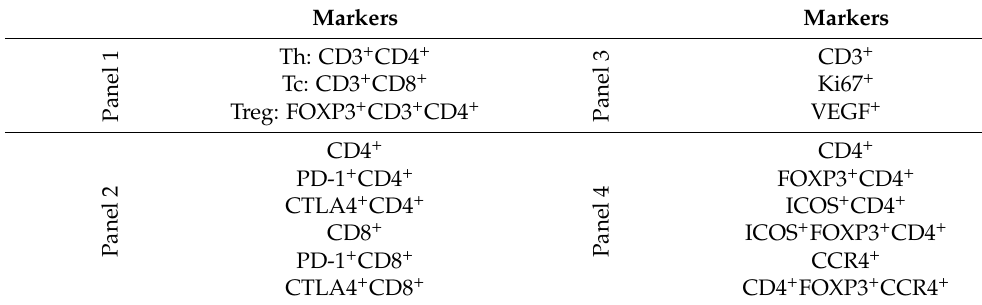
Table 2. Immune cell phenotypes in Panels